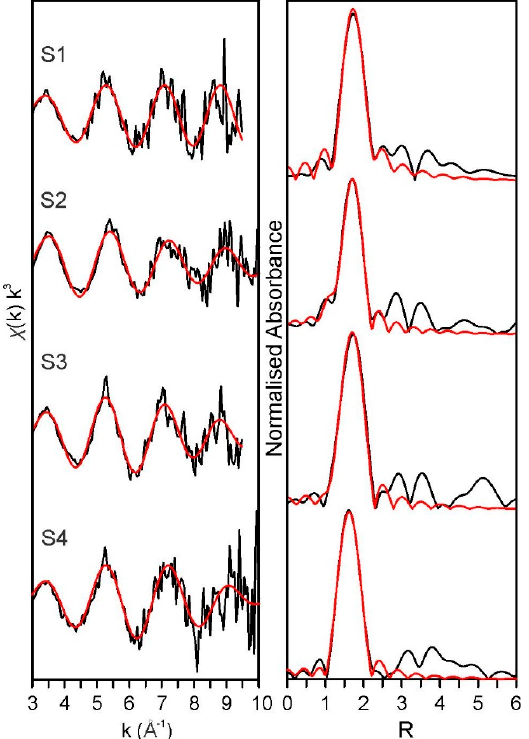
Figure 7. Summed Pu L 3 edge EXAFS spectra from the four cement samples (see Table 1 for sample details) with their corresponding fits (red lines). Data are presented as k 3 alongside non-phase-corrected Fourier transforms.